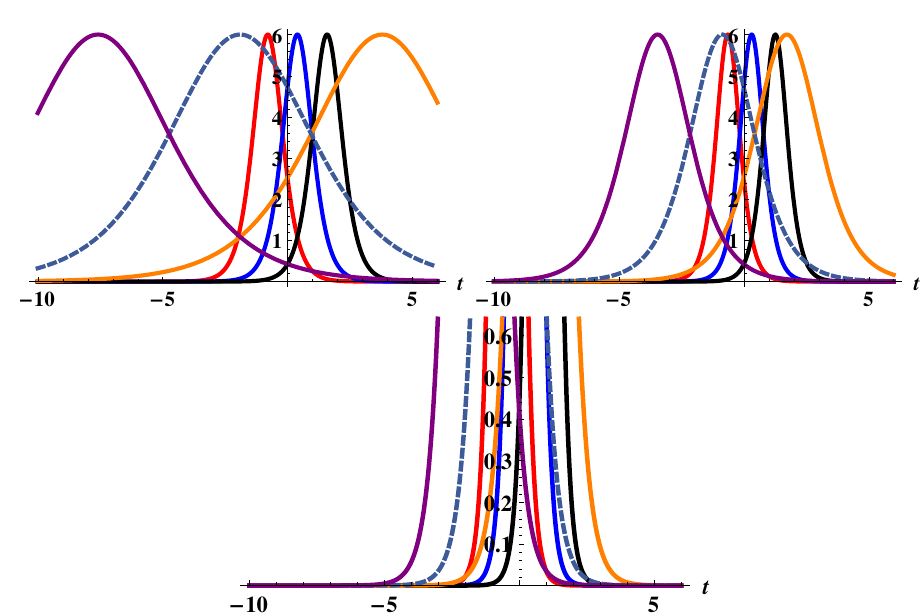
Figure 2. The profile of solutions describing the interaction of the two-wave solitons given by (27) upon increasing the phase velocity, for s = 0.5, 1, 2, respectively. Here γ 1 = 1/2, γ 2 = 1/3, a = b = µ = d = k =